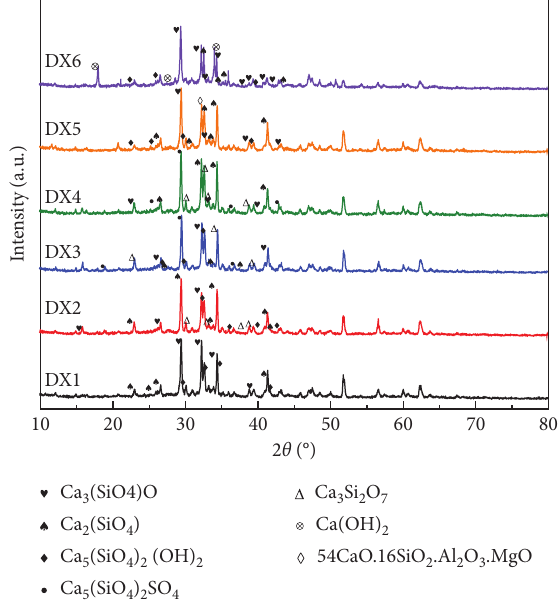
Figure 8: XRD spectra of hydrates of